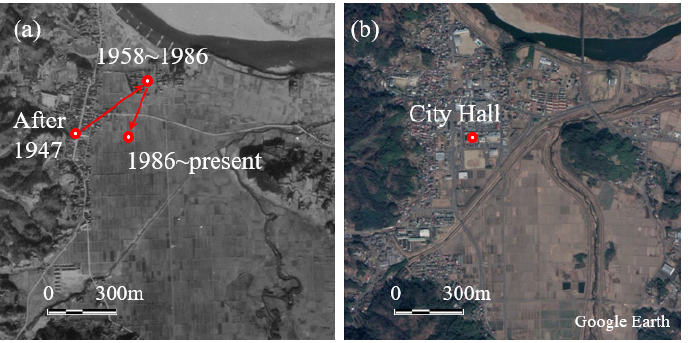
Figure 2. Changing location of the City Hall: ( a ) on the 1947 aerial photo, ( b ) on the 2019 Google Earth Image.